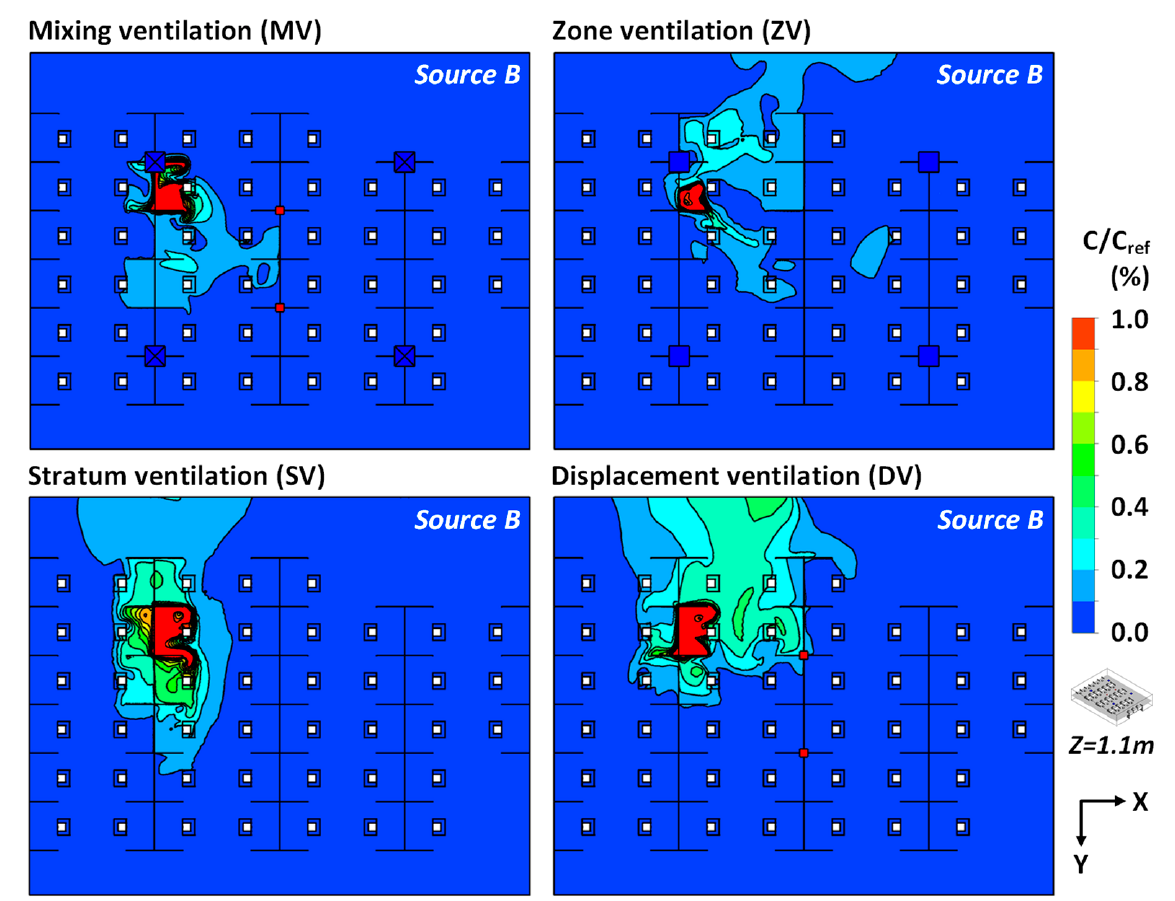
Figure 7. Distribution of relative pollutant concentration (C/C ref ) at the plane of Z = 1.1 m under different ventilation modes of MV, ZV, SV and DV and infected source of B (with a height of physical barrier of 0.6 m).